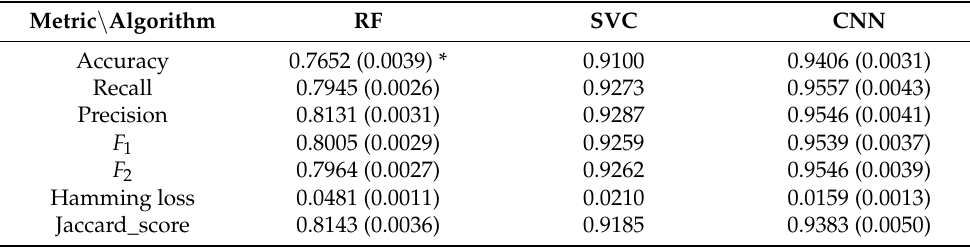
Table 6. Classification performance in experiment 3. Metric \ Algorithm